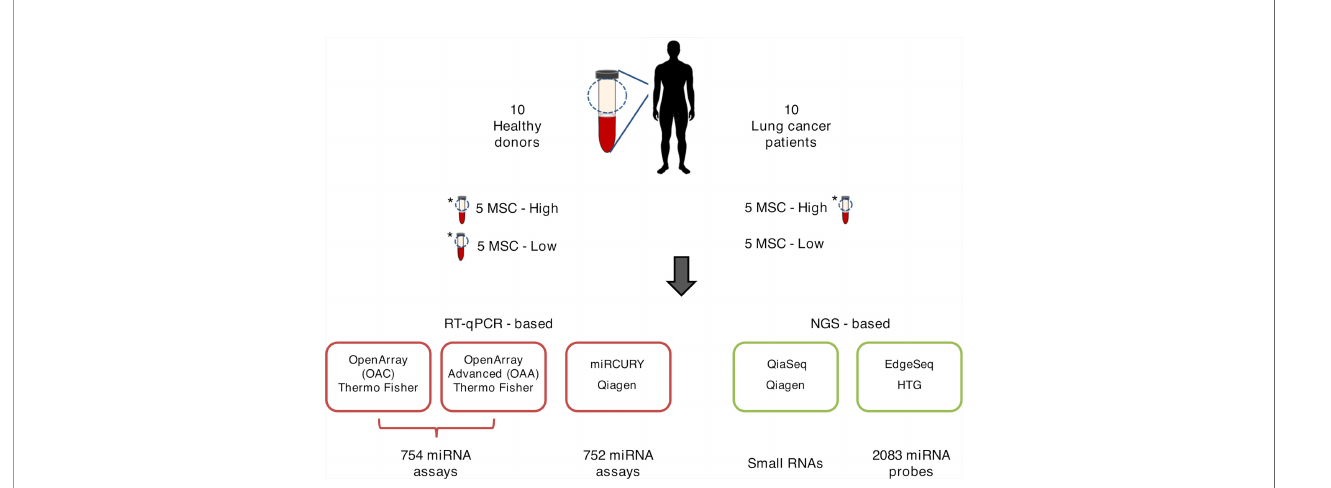
FIGURE 1 | Graphical representation of ct-miR pro fi ling in non ‐ small cell lung cancer (NSCLC). The plasma samples of ten stage IV NSCLC cancer patients and ten healthy heavy smoker donors were quanti fi ed for miR expression by fi ve different high-throughput platforms — three qPCR-based (lower-left panels, boxed in red) and two next-generation sequencing-based (lower-right panels, boxed in green). Three samples were tested in duplicate and are marked with an